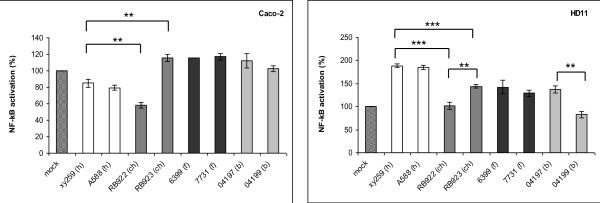
Differential NF-κB activation or inhibition by various ST-21 C. jejuni strains in mammalian cells. Stably transfected Caco-2 cells (A) and HD-11 cells (B) containing a NF-κB-luciferase gene fusion were coincubated with 8 different C. jejuni strains (from human (h), chicken (ch), bovine (b) and food (f) source) at an MOI of 50 in triplicates and coincubated for 1 h. The values are depicted in percent relative to the mock-infected sample, which was set to 100%. One representative experiment of four is displayed. Statistics was performed using a Student's t test. A p-value of < 0.05 was considered statistically significant (* p ≤ 0.05, ** p ≤ 0.01, *** p ≤ 0.001). Selected statistical evaluation of differences between strains from one source or between two different sources is shown.